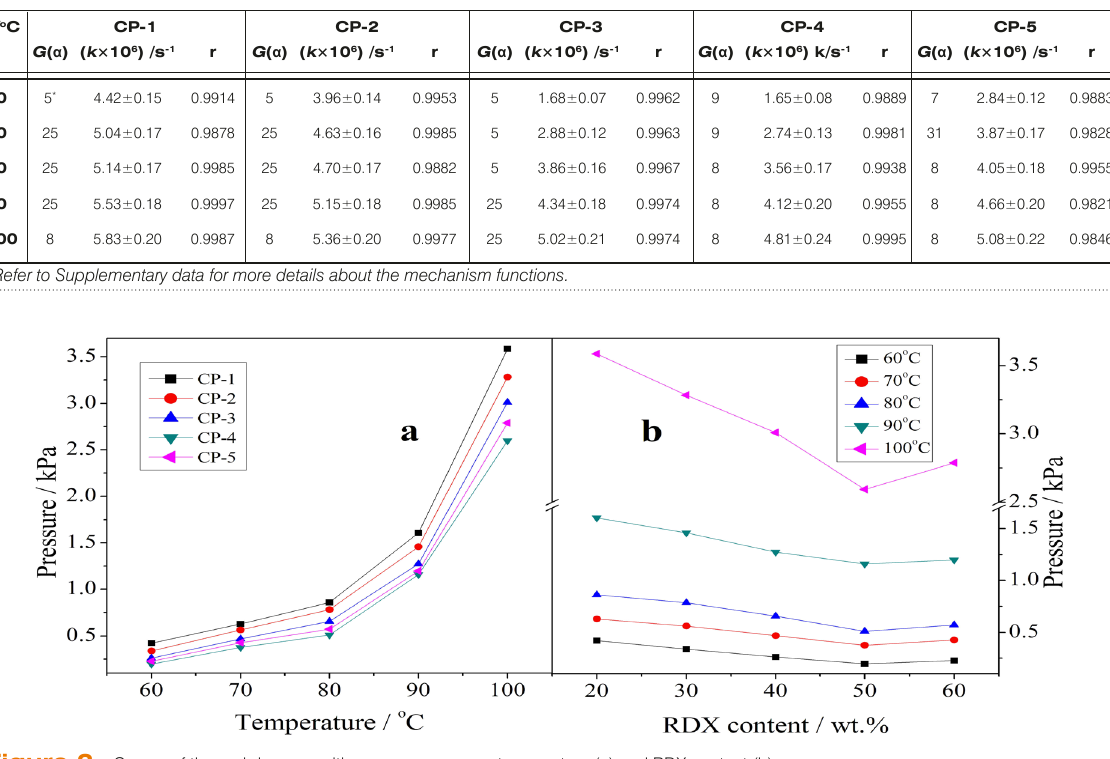
Table 3. Isothermal kinetic parameters of the composite propellants at different temperatures.